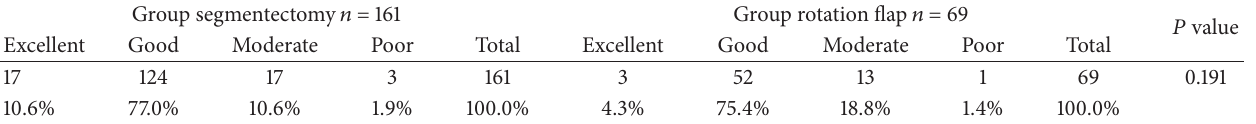
Table 3: BCCT.core